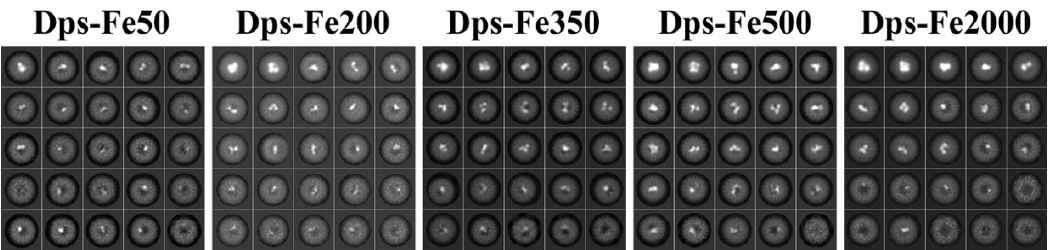
Figure A1. Class averages of Dps dodecamers with an estimated iron loading of between 50–2000 atoms (left to the right) after 3h incubation showing different morphologies of the iron cluster. Each of 2D class averages is 12.5 nm wide.